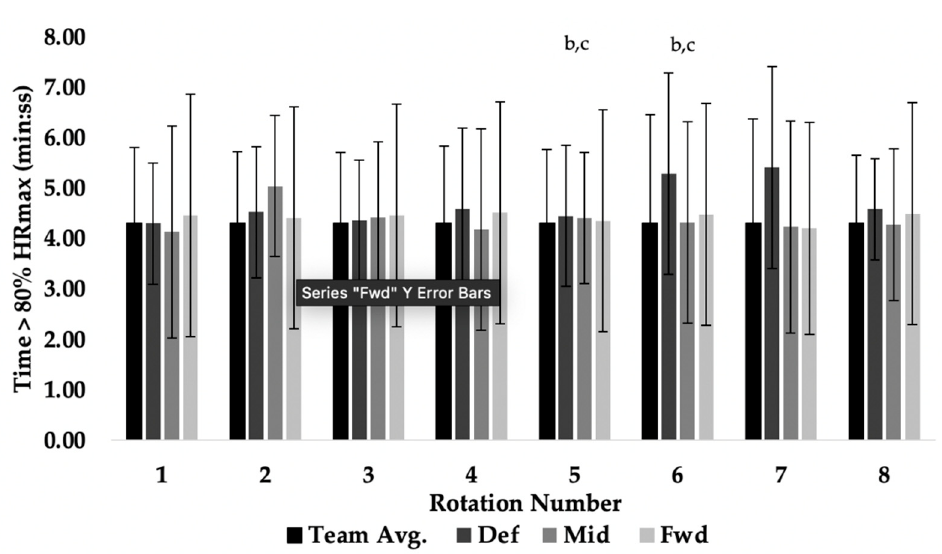
Figure 3. The average time spent > 80% HR max (min) of elite female field hockey players across each rotational period during competitive match-play. The letters a, b, c signify the positional variation between the defenders ( a ), midfield ( b ) and forwards.